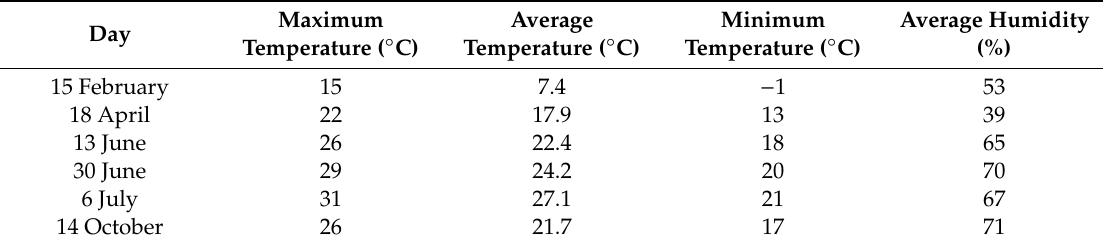
in building 8I–8J .